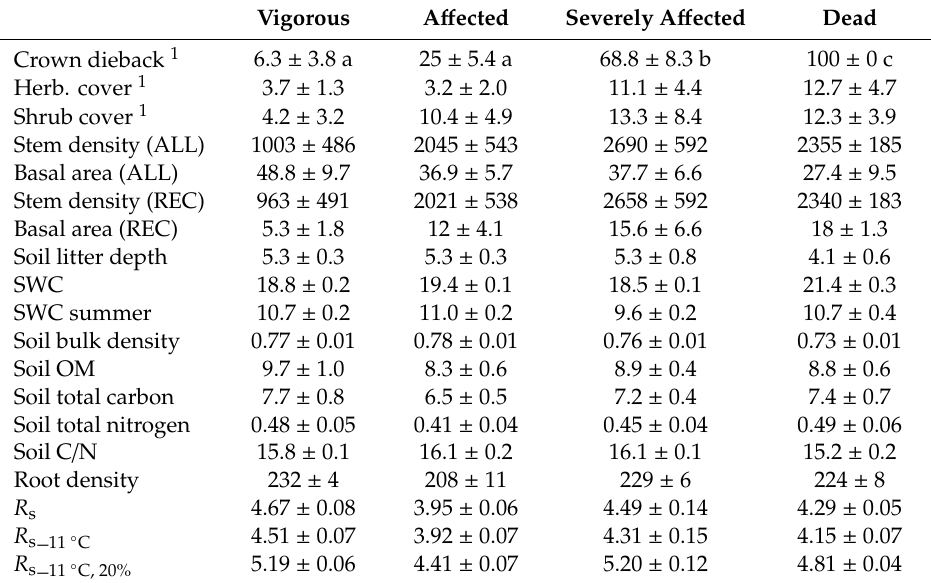
1 : Variables visually estimated by the same